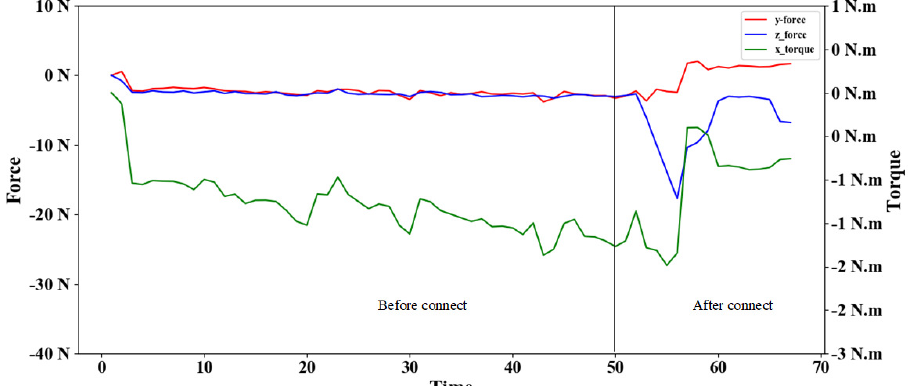
Figure 15. The end contact force and torque during